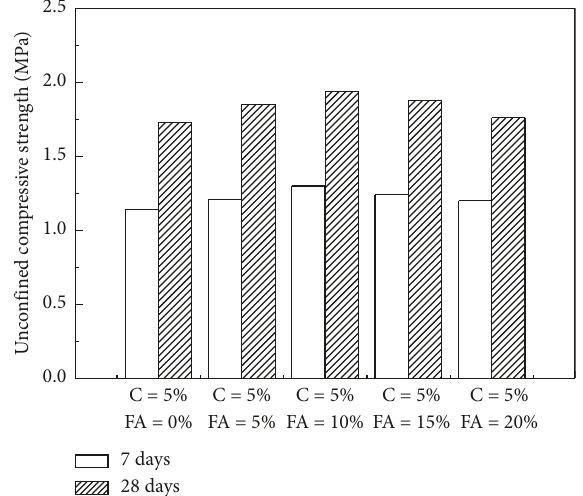
Figure 9: Unconfined compressive strength of cement-fly ash- stabilized